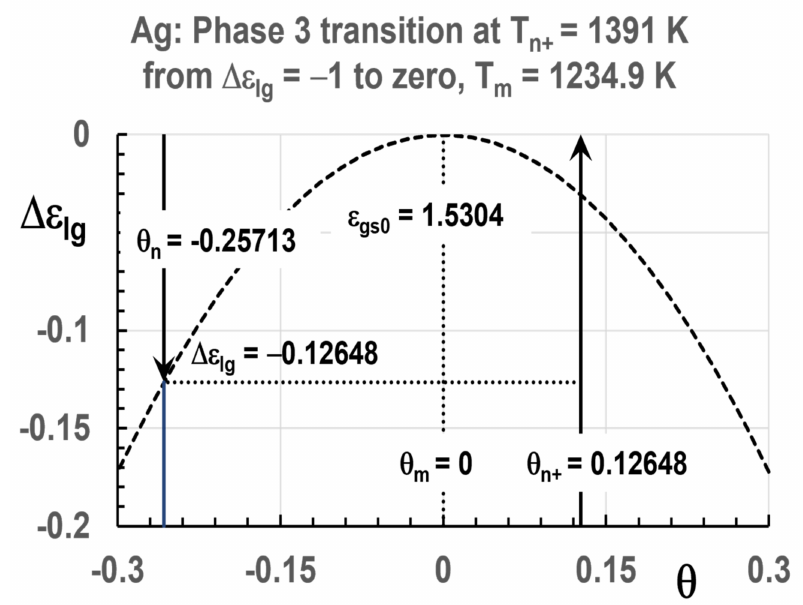
− 1 due to the proximity of T m . Melting at lg =